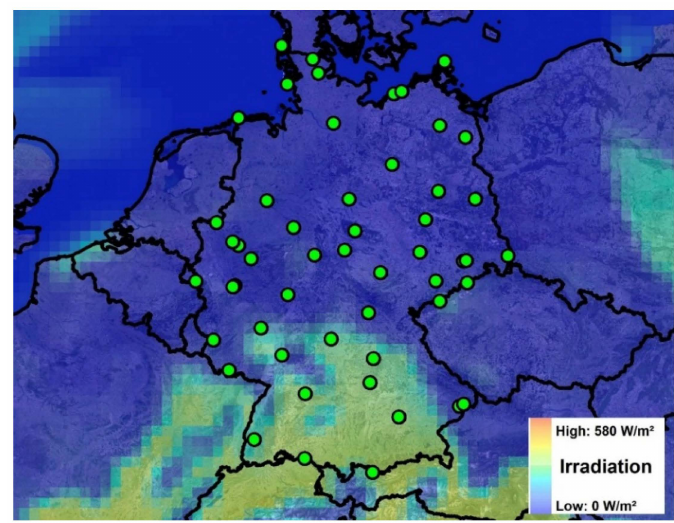
Figure 1. Grid structure of the model data available on a 20 km ˆ 20 km scale ( colored rectangles ) and location of the 57 measurement stations ( green dots